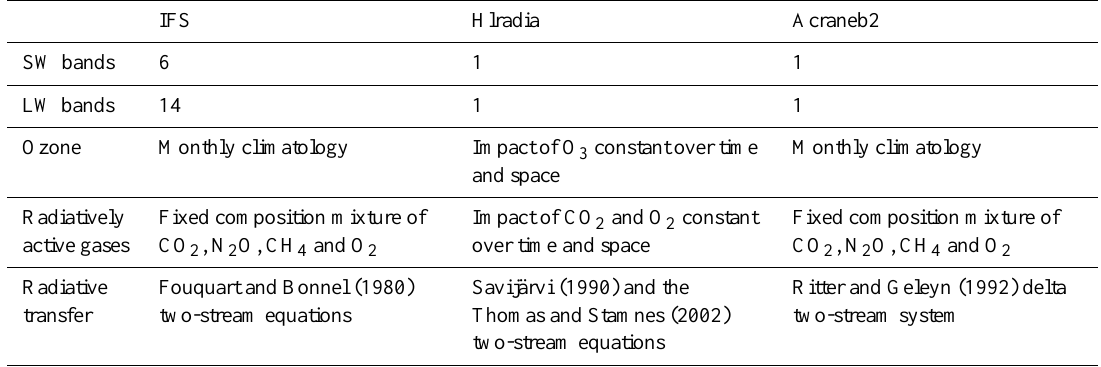
Table 1. Summary of aerosol radiation experiments including details of the radiation schemes and aerosol data sets used. IFS Hlradia Acraneb2 SW bands 6 1